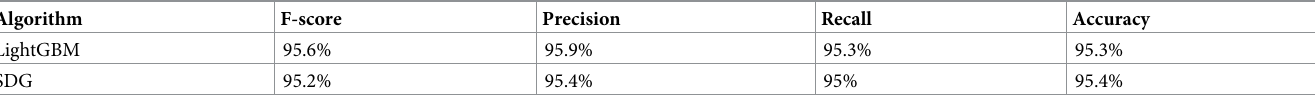
Table 5. Market_D performance.